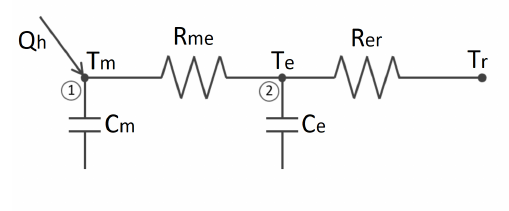
Figure 3: RC network analogy of the heat